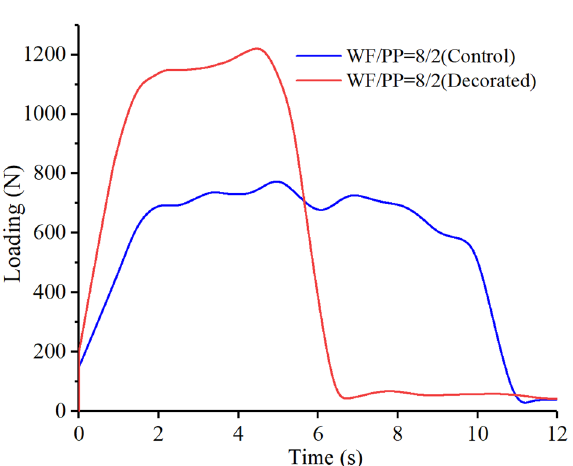
Figure 17. The low-velocity impact loading-time curve of the WF/PP = 8/2